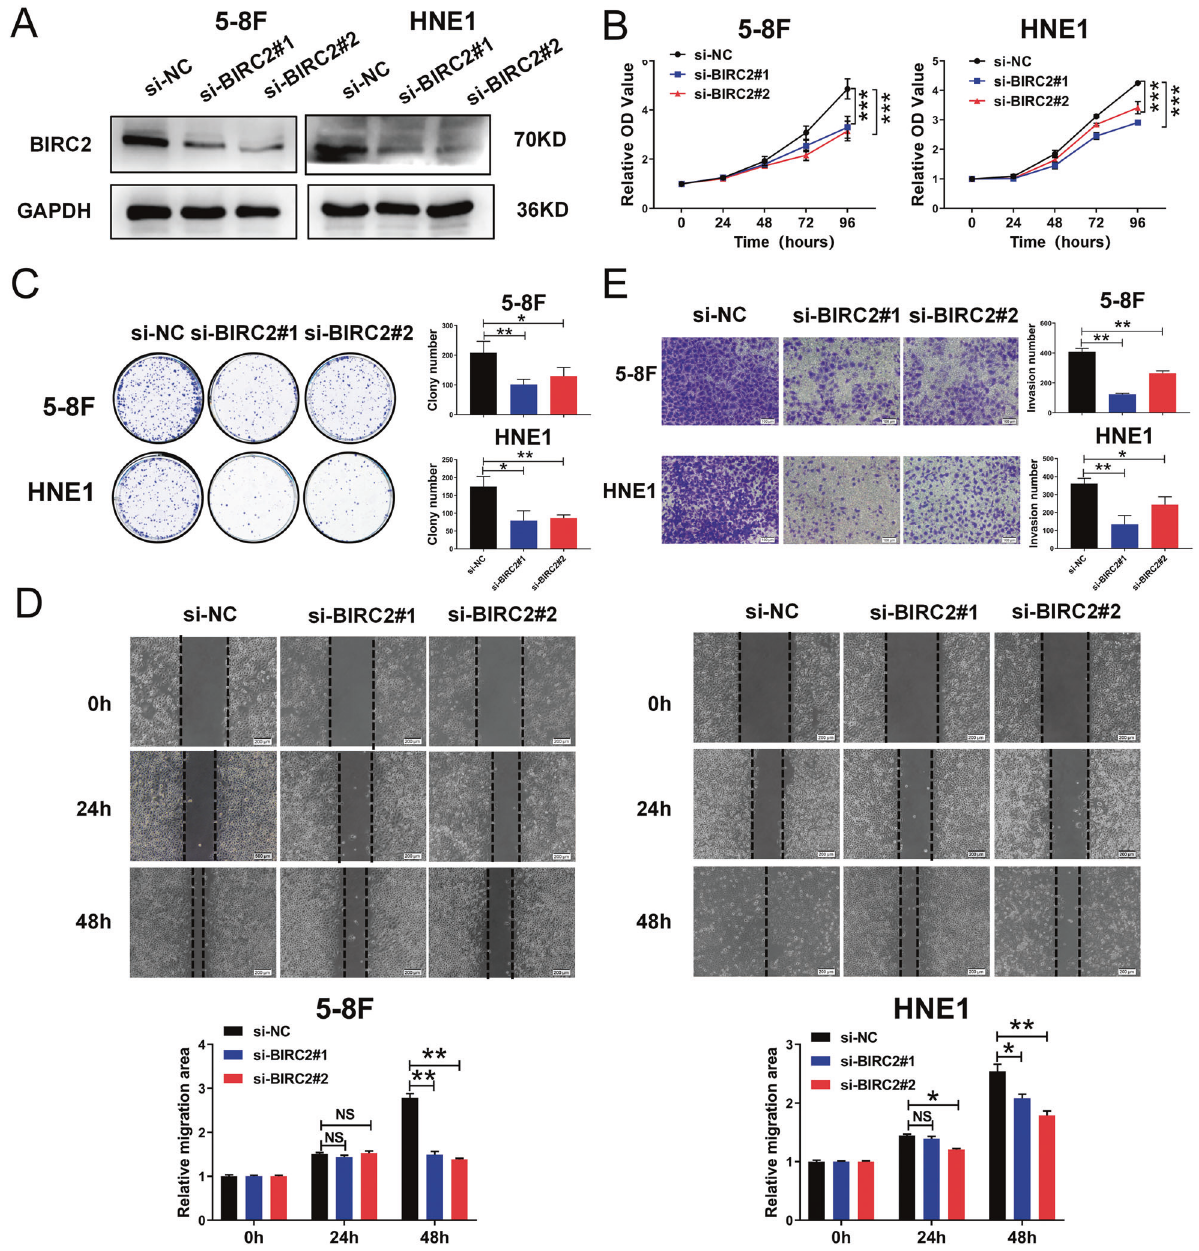
Fig. 3 Depletion of BIRC2 by siRNA promotes cell proliferation and metastasis in NPC cell lines. A 5-8 F or HNE1 cells were transfected with scrambled siRNA (negative control) and BIRC2 siRNA #1, #2, respectively. Western blotting was used to analyze the silencing ef fi ciency of BIRC2, and GAPDH served as an internal control. ( B ) and ( C ) Cell growth was measured by the CCK-8 assays and colony-forming assays of 5-8 F and HNE1 with transfection of BIRC2 siRNAs or negative control. D Cell migration assay was performed with the scratch wound healing analysis. E Matrigel invasion analysis of cell invasive capabilities in 5-8 F and HNE1 with transfection of BIRC2 siRNAs or negative control. Error bars represent the mean ± SD. *P < 0.05, **P < 0.01, ***P < 0.001; NS, no signi fi cance. All experiments were performed in